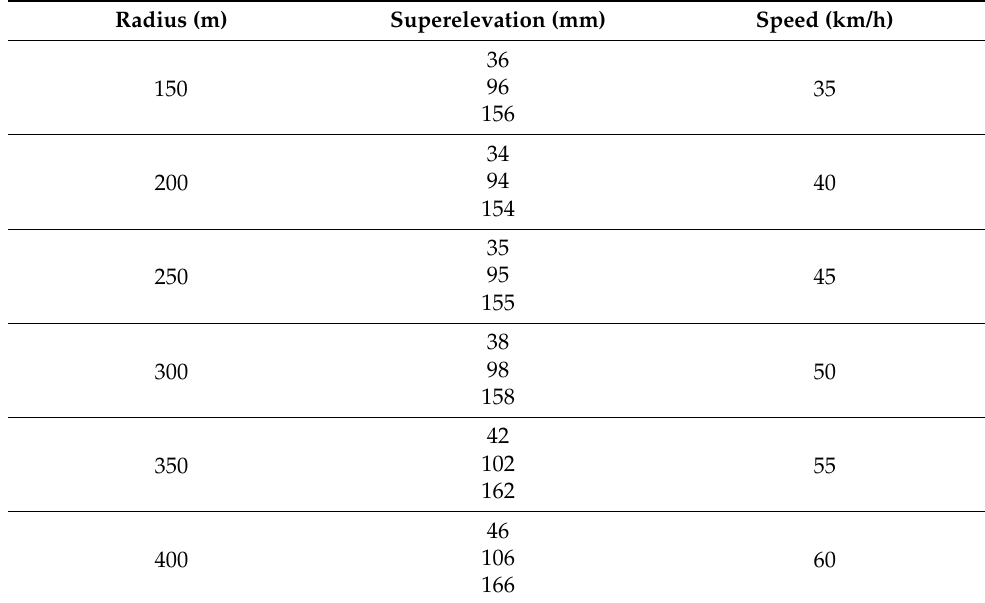
Table 16. Calculated working